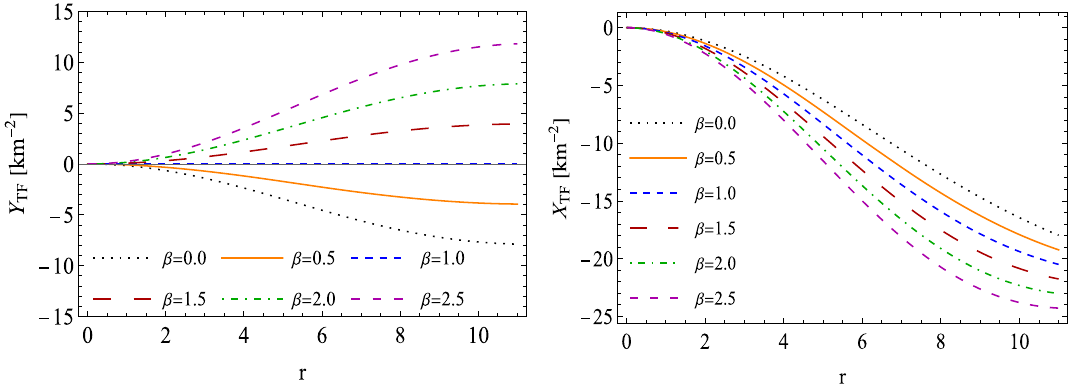
Fig. 2 Left panel: The behavior of complexity factor ( Y TF × 10 4 ) against r with different β is shown, and Right panel: shows the trend of density inhomogeneity X TF × 10 4 against r for different β for solution 5.1 with same numerical values as used in Fig.1